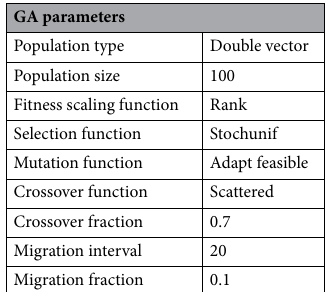
Table 3. The parameters and functions used in MATLAB genetic algorithm function.